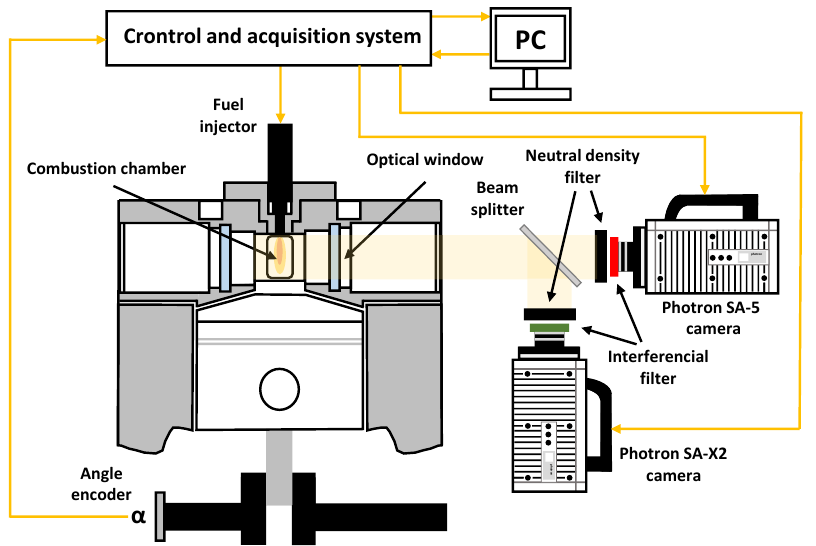
Figure 5. Scheme of the two-color pyrometry system